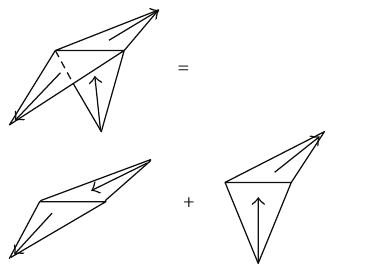
Figure 4: Division fashion of pair of triangles in this paper.